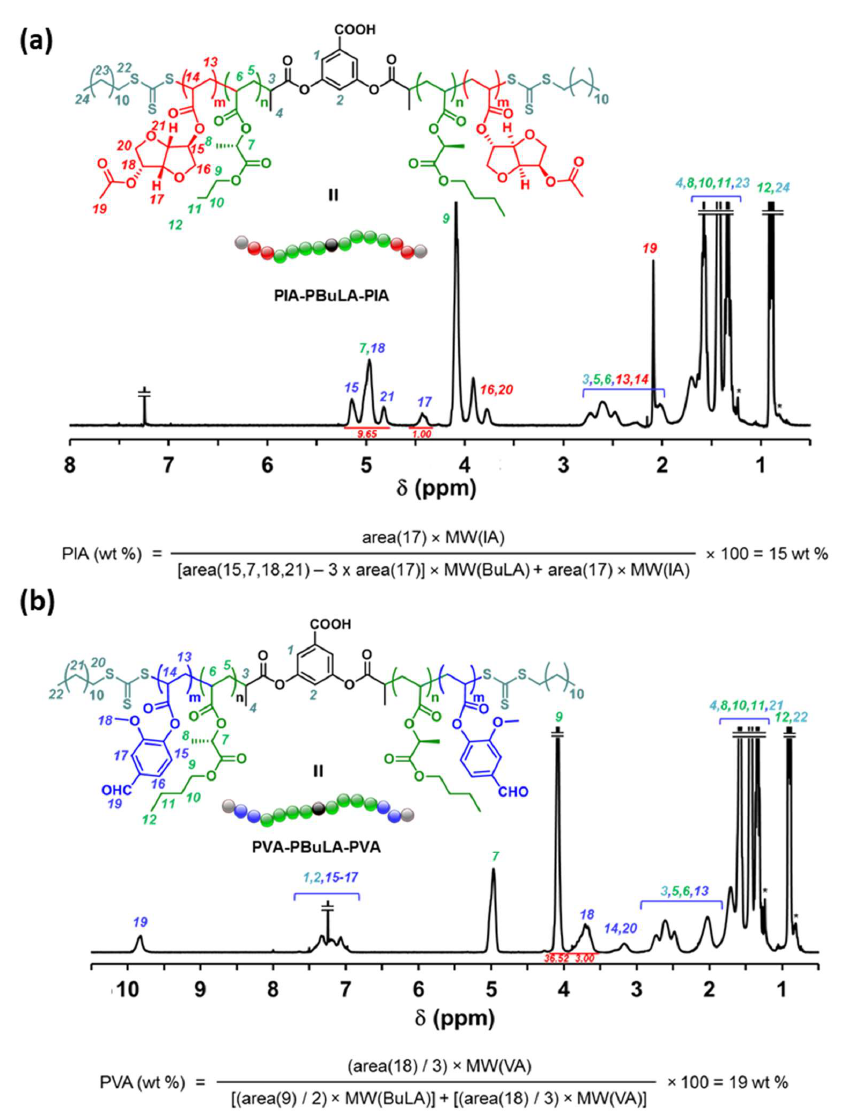
Figure 8. 1 H NMR spectra of: ( a ) PIA-PBuLA-PIA ( M n,GPC = 103,500 g · mol − 1 , M w / M n = 1.28); and ( b ) PVA-PBuLA-PVA ( M n,GPC = 110,150 g · mol − 1 , M w / M n = 1.38) triblocks in CDCl 3 . 1 H NMR resonances from “grease” impurities are indicated with